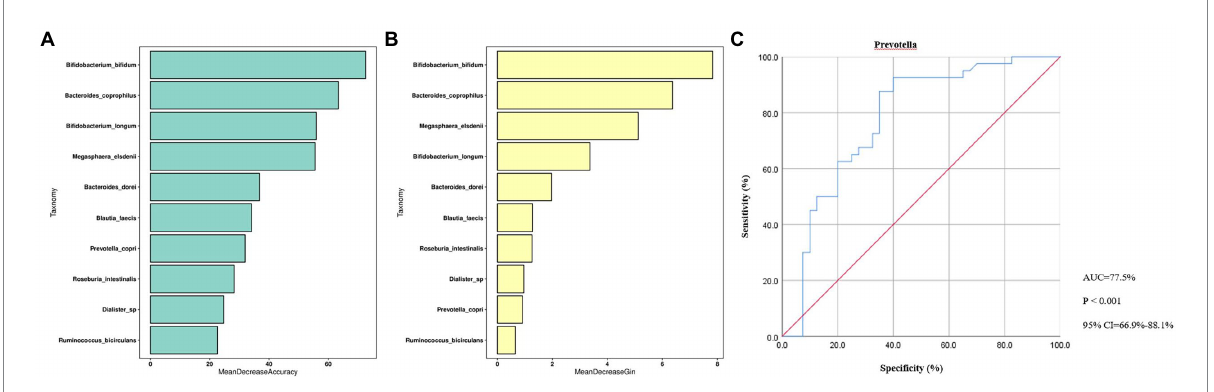
FIGURE 5 Random Forest Analysis. (A) , Mean Decrease Accuracy; (B) , Mean Decrease Gin; (C) , ROC curve. ROC, receiver operating characteristic; AUC, are under curve; CI, confidence interval; p < 0.01, dramatically statistical